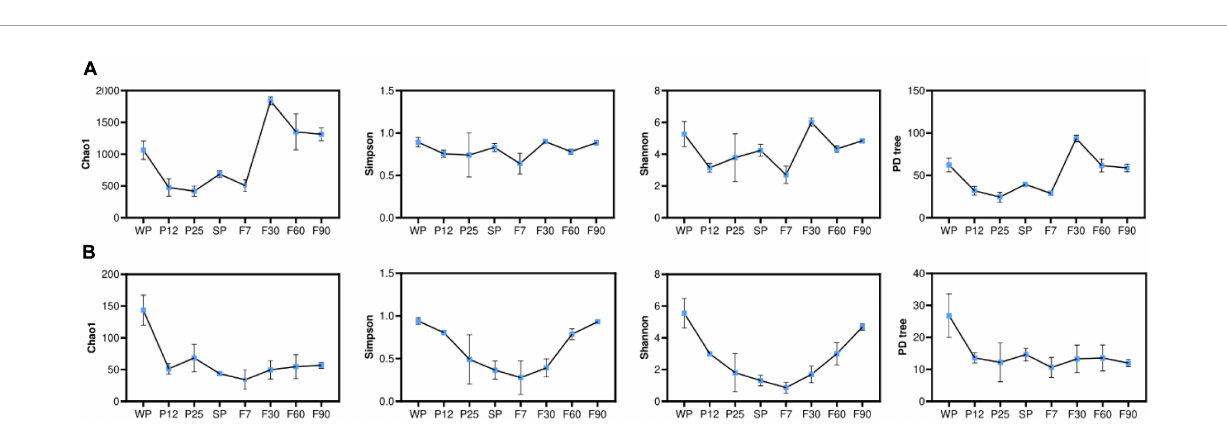
FIGURE5 Analysis of alpha diversity index of bacteria (A) and fungi (B)